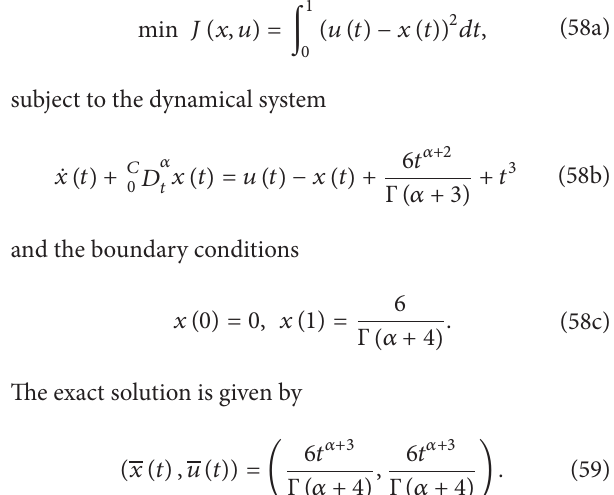
Figure 7: Exact and approximate state.